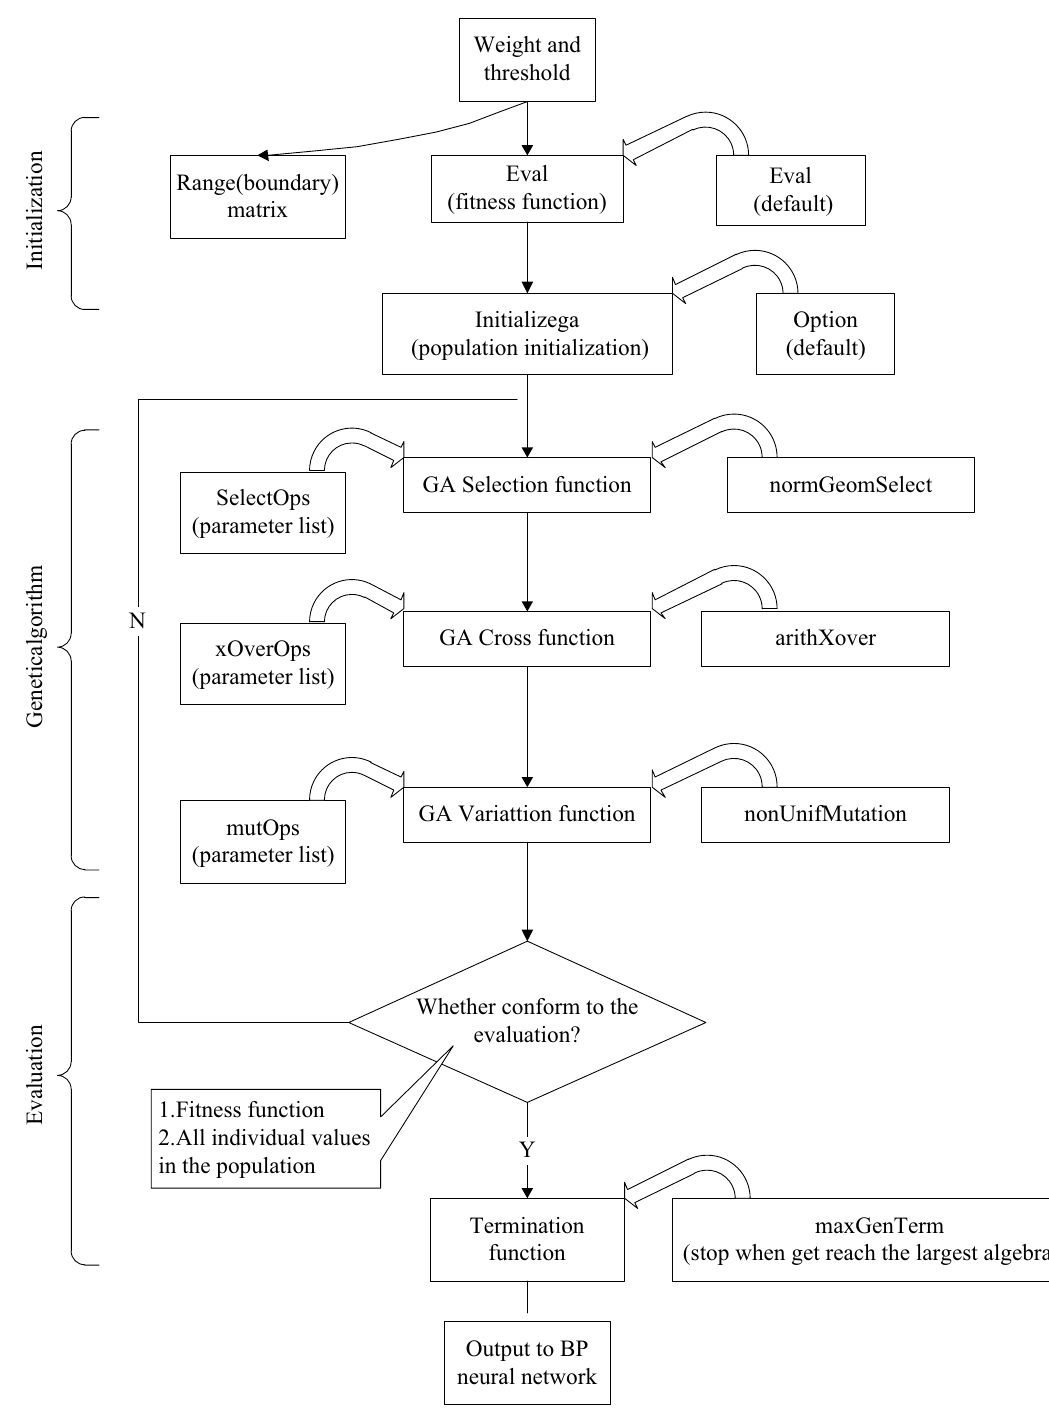
Fig. 3 Running process chart of basic training parameters based on GA-BP neural